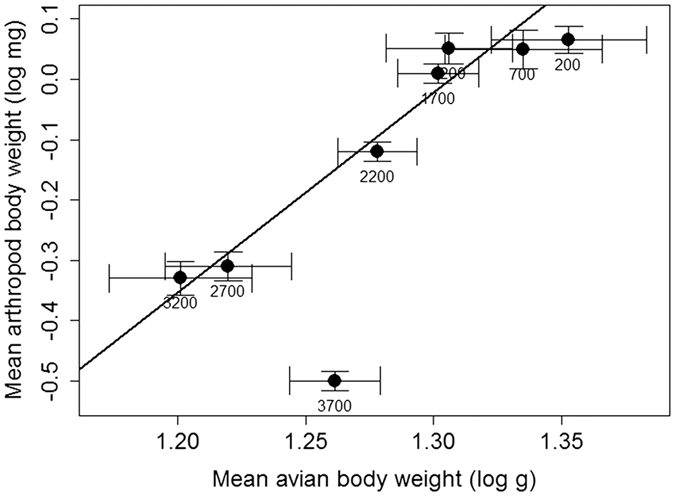
Relationship between mean log (body weight) of bird individuals and arthropod prey in their food samples.Each point represents one bird community. Mean arthropod weight = 3.3999*Mean avian weight −0.2407, R2 = 0.941, P > 0.001, F1,7 = 69.87. Note that data for 3700 m are not included in the regression.